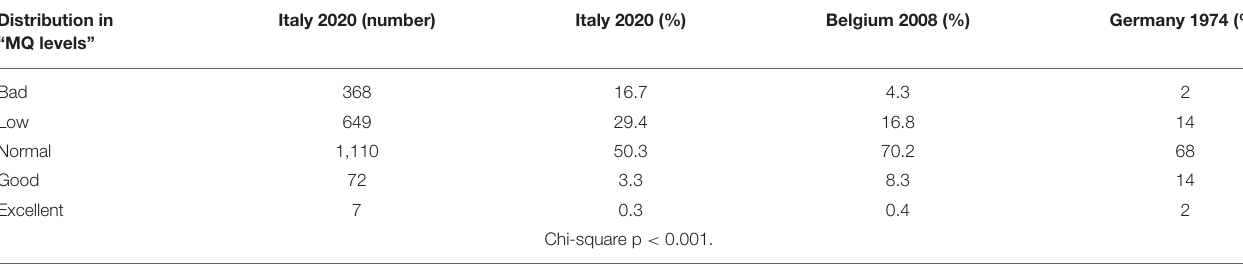
TABLE 6 | Distribution of subjects in the five levels of motor quotient (MQ level) of three comparable searches. Distribution in “MQ levels”